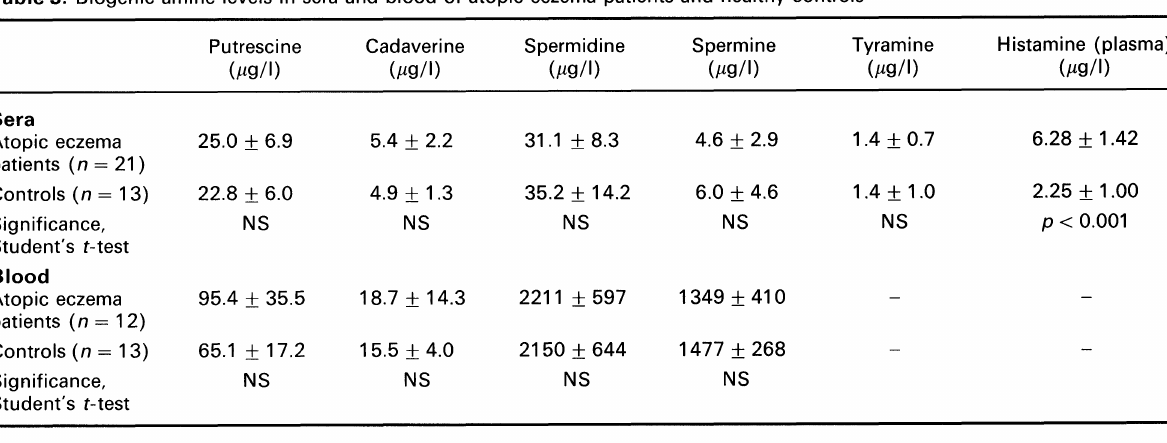
Table 3. Biogenic amine levels in sera and blood of atopic eczema patients and healthy